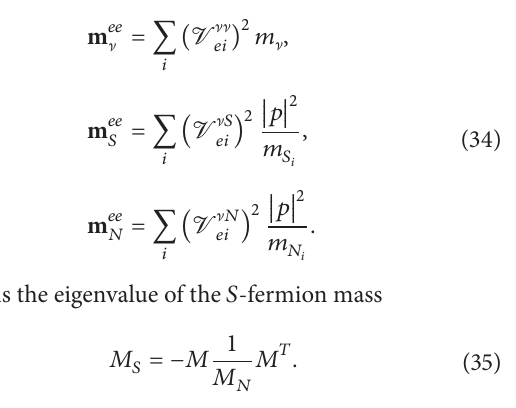
𝐾 = 1.57 × 10 −25 yrs −1 eV −2 , and the two effective mass 0 ] parameters